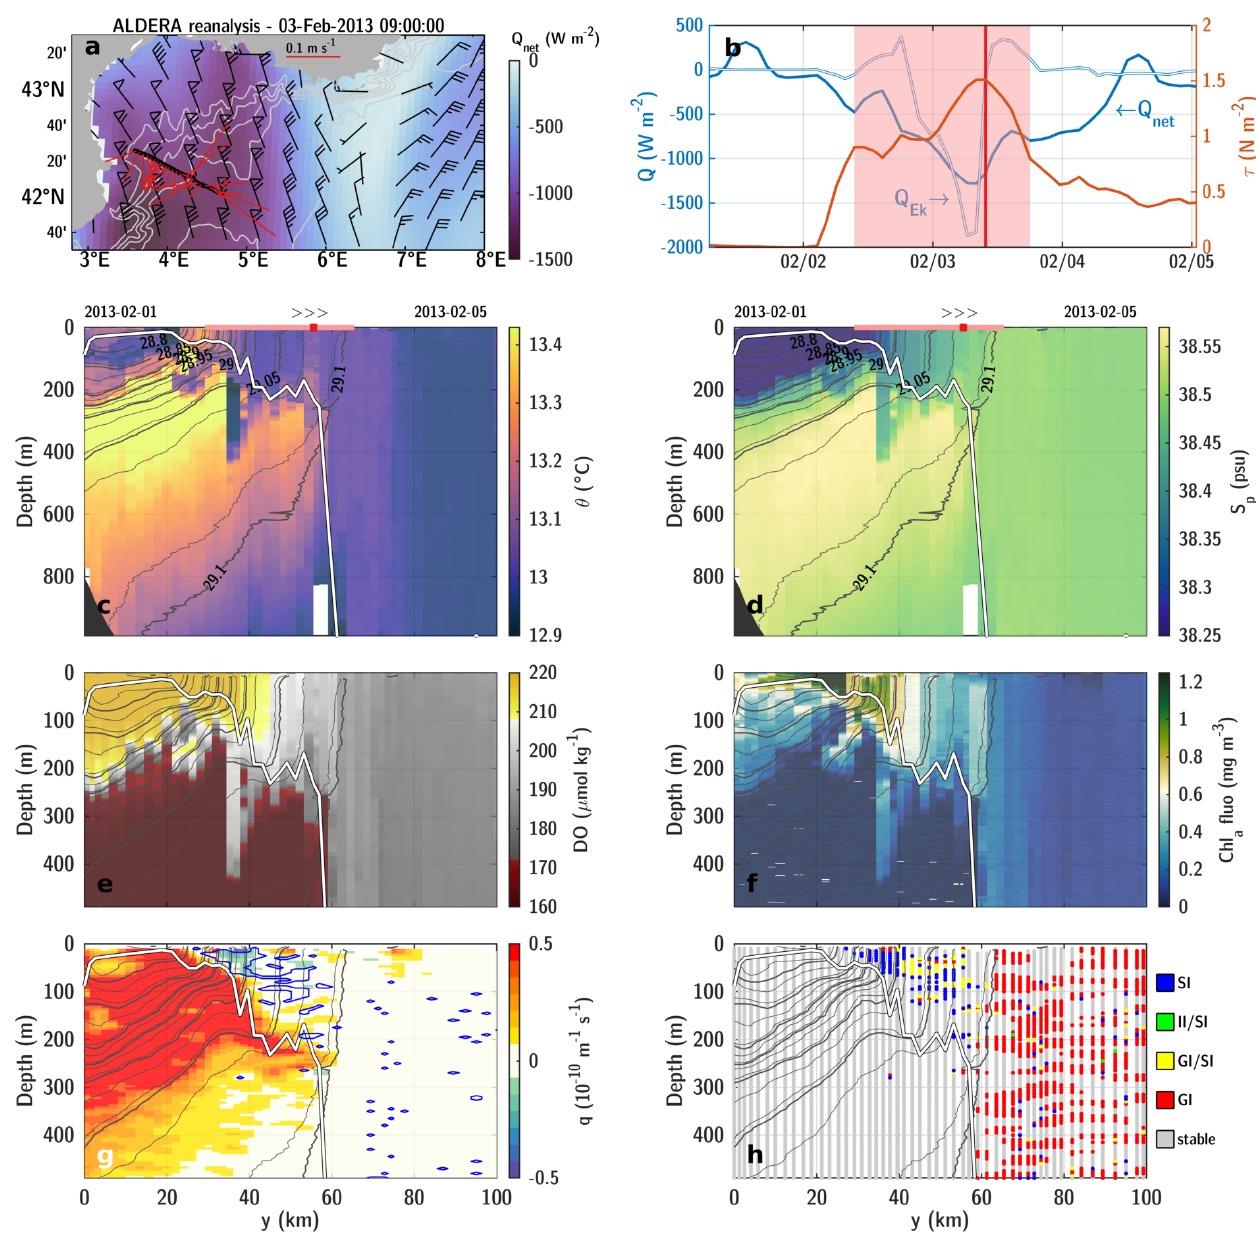
Figure 11. Glider sampling of SI event 9 in Table 2. ( a ) Net surface heat flux and winds on February 3rd from CNRM- ALADIN reanalysis. ( b ) Net surface heat flux (i blue), Ekman equivalent heat flux (in white) and wind stress (in red) along the glider track. The red bar shows the peak of the wind event on February 3. Glider sections of ( c ) potential temperature, ( d ) practical salinity, ( e ) dissolved oxygen (uncalibrated), ( f ) chlorophyll-a fluorescence (quality-controlled with satellite, see Section 2.1), ( g ) potential vorticity with contours of SI layer in blue, ( h ) instability categories. On panels ( c – h ), the gray contours are isopycnals and the white line shows the mixed layer